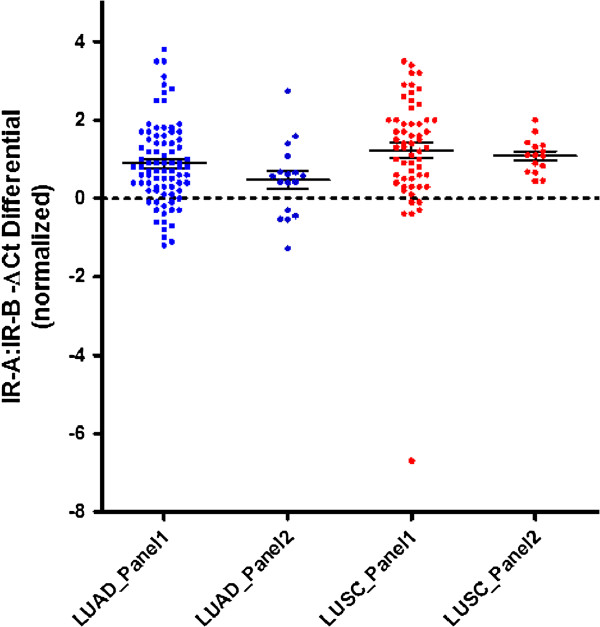
TaqMan qRT-PCR confirmation of IR-A/IR-B mRNA ratio in NSCLC primary tumors using cDNA array. The IR-A/IR-B mRNA ratio was assessed by determining ΔCt differentials of IR-A and IR-B in lung cancer and normal lung samples. The ΔCt differential (IR-B ΔCt – IR-A ΔCt) values were calculated for each specimen utilizing the within-specimen reference gene panel (average Ct) and normalized to the average of the normal lung samples. The error bars represent the mean -ΔCt ± 95% CI within a particular gene target and sample-type combination. Dotted line indicates average levels of IR-A/IR-B ratios in normal lung tissues.